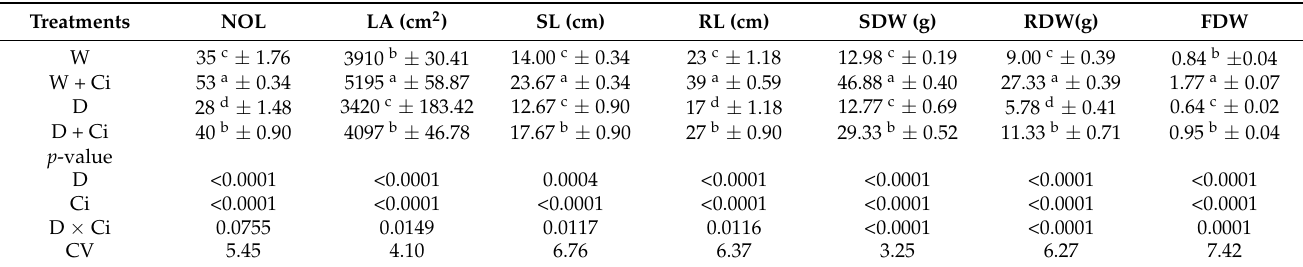
Table 1. Number of leaves (NOL), leaf area (LA), shoot length (SL), root length (RL), shoot dry weight (SDW), root dry weight (RDW), and flower dry weight (FDW) of Calendula officinalis applied with foliar application of chitosan (7.5 mg L − 1 ) at 100% FC (W), 60% FC (D).